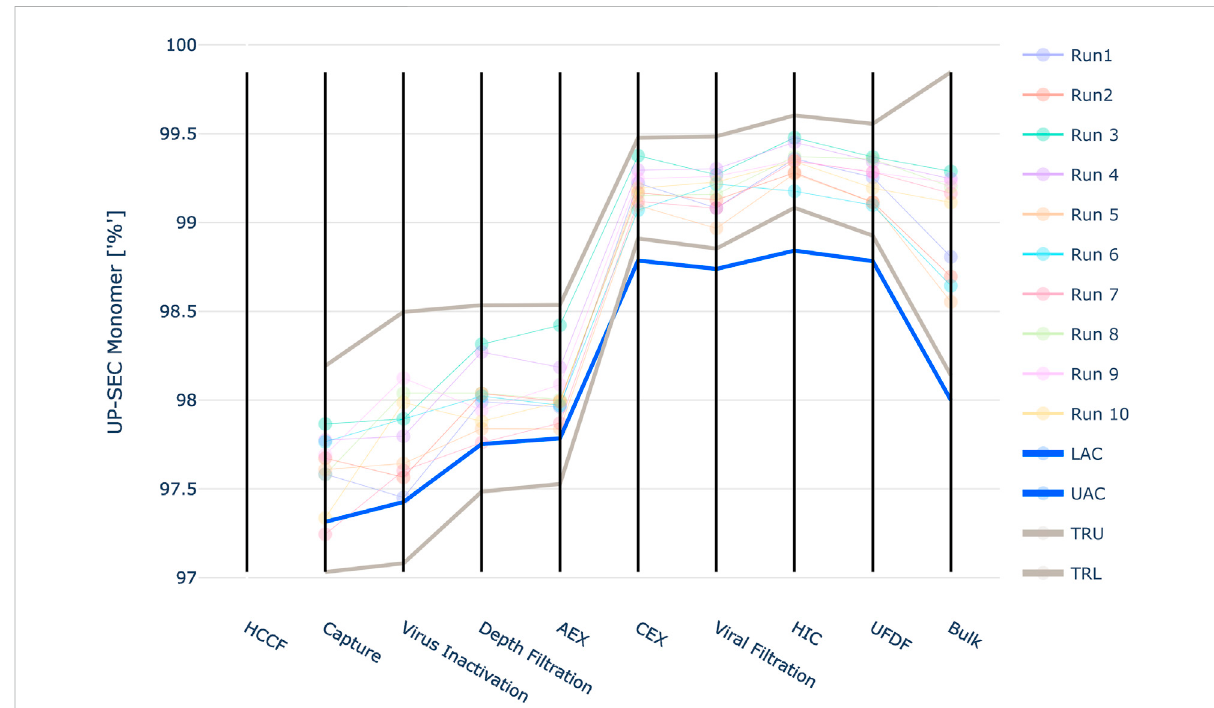
FIGURE 11 Graphical representation of the intermediate acceptance criteria (blue line) across the entire downstream process for the response UP-SEC Monomer.Availablelarge scale,manufacturingdataperbatch(circles)and3standard deviationranges (greylines)aregivenaswell.TheshowniACs at DS are the DS speci fi cation